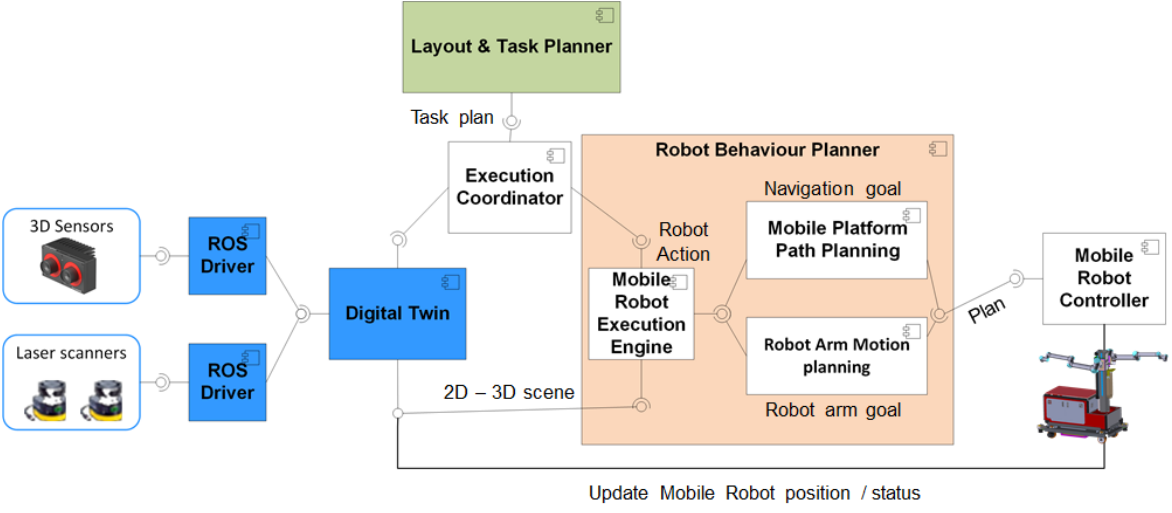
Figure 8. DT-based system component diagram.